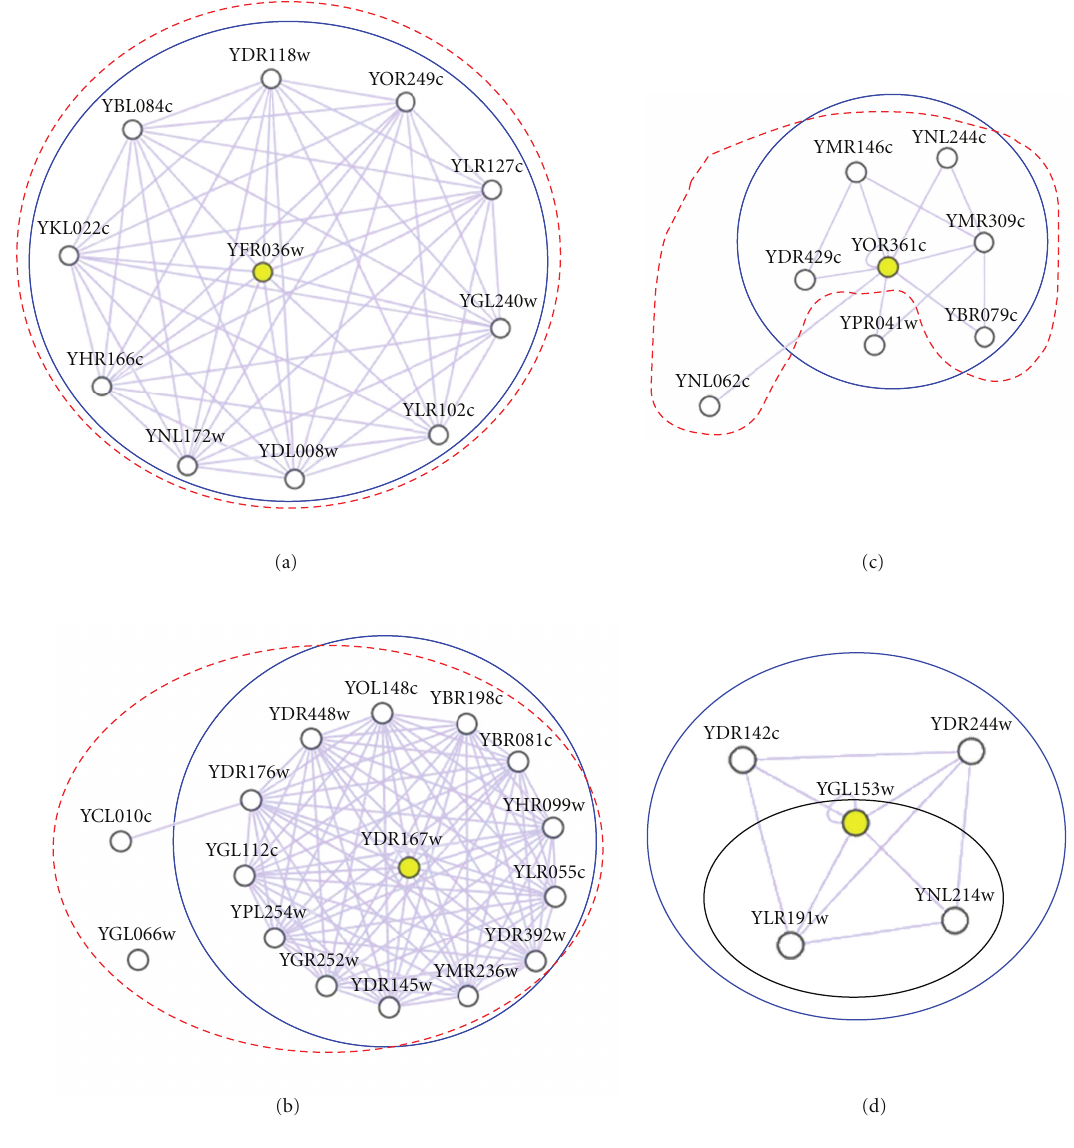
Figure 6: Examples of clusters predicted by HKC in MIPS data set. The nodes encircled by the red-dotted line are known complex in the complexcat benchmark, the nodes contained within the blue circle are clusters predicted by HKC, and the yellow node in each cluster denotes the seed of the cluster. (a) A cluster of size 11 perfectly matches with the TRAPP complex. (b) A cluster of size 14 shares 14 proteins with the SAGA complex (size 16), and their overlap ratio is 0.93. The two proteins YCL010c and YGL066w that are not contained in the predicted cluster are isolated nodes with only one edge connecting with the cluster. (c) An example of a well-matched cluster, involving 7 proteins, among which 6 is in common with the complex of cytoplasmic translation initiation factor 3 (eIF3). (d) A novel cluster detected by HKC, which does not match with any known protein complexes in the complexcat benchmark, and the proteins in the black circle form the docking complex that facilitates the import of peroxisomal matrix proteins according to GO